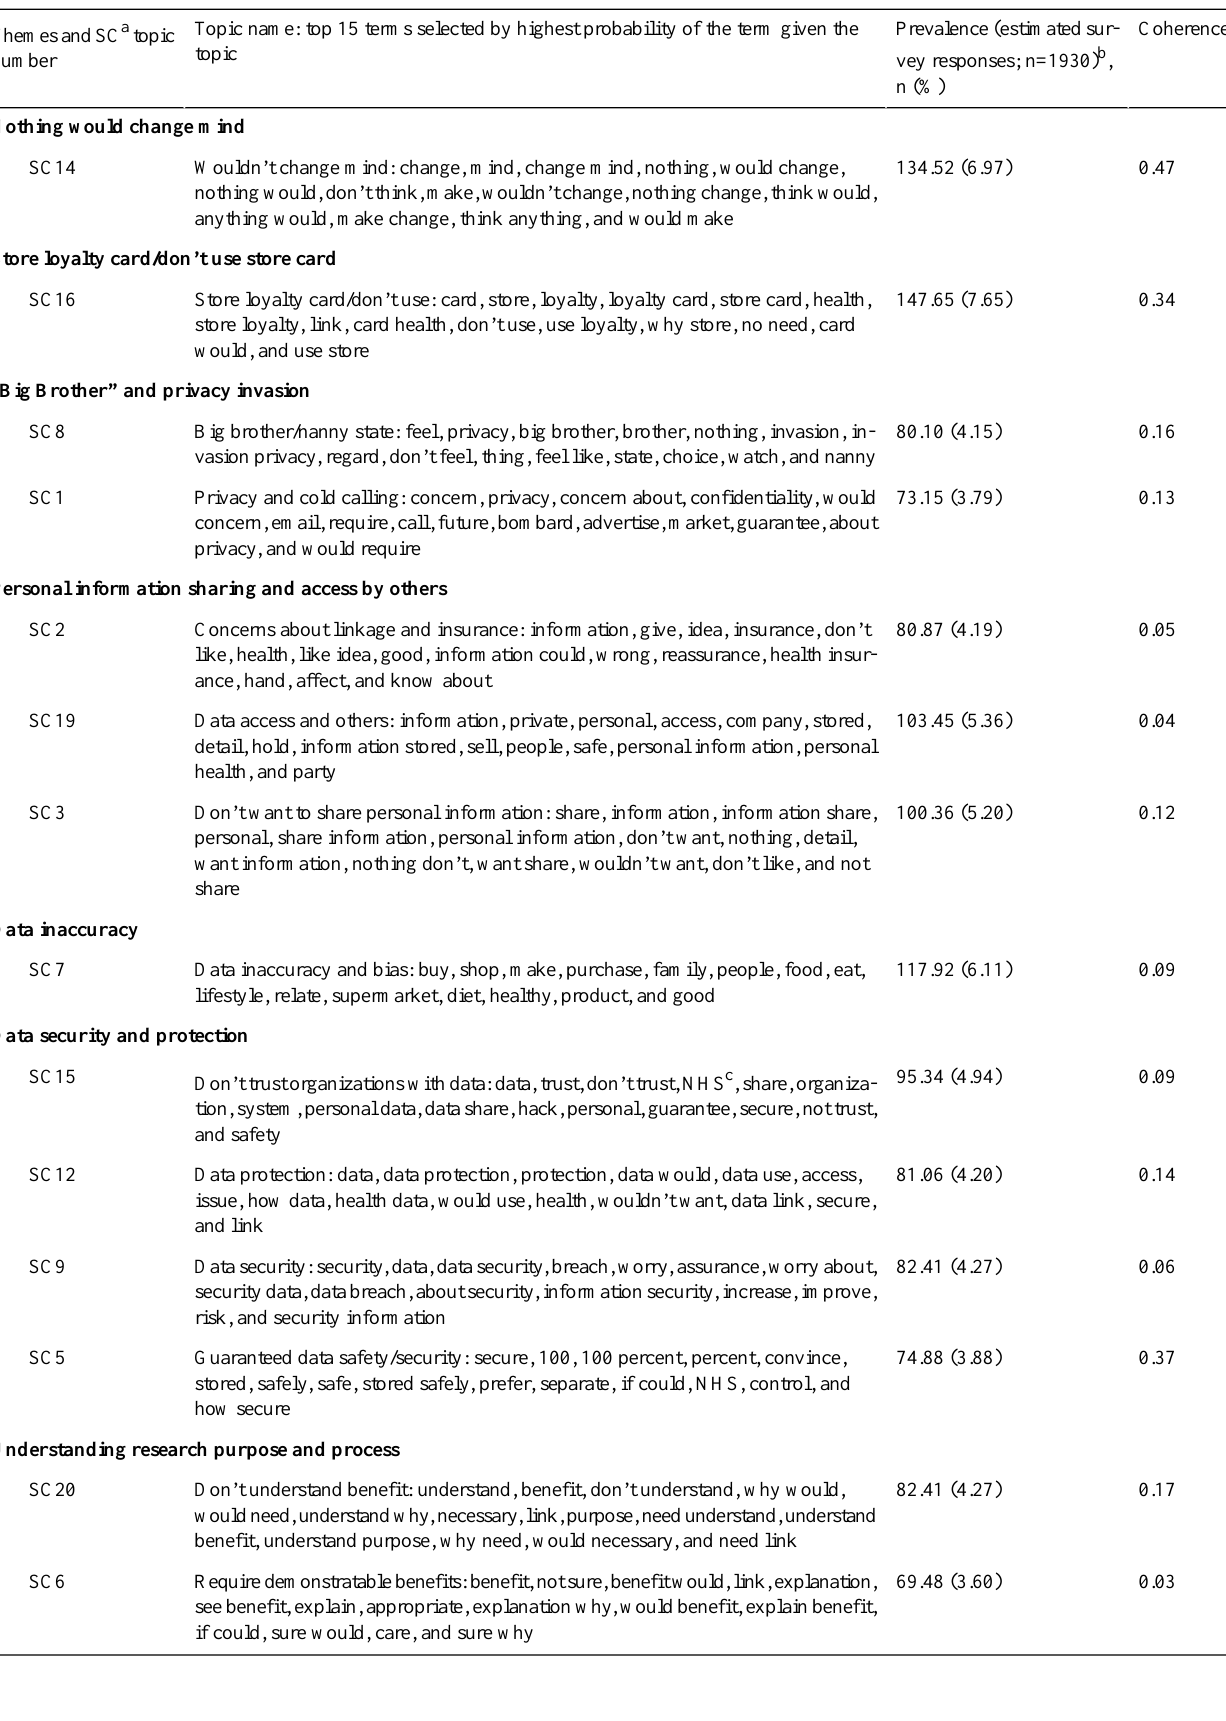
Table 3. Topics created by latent Dirichlet allocation modeling of LifeInfo store loyalty card question, showing topic names, top 15 terms per topic according to term ϕ values, topic prevalence, and topic probabilistic coherence. In total, 9 thematic categories are